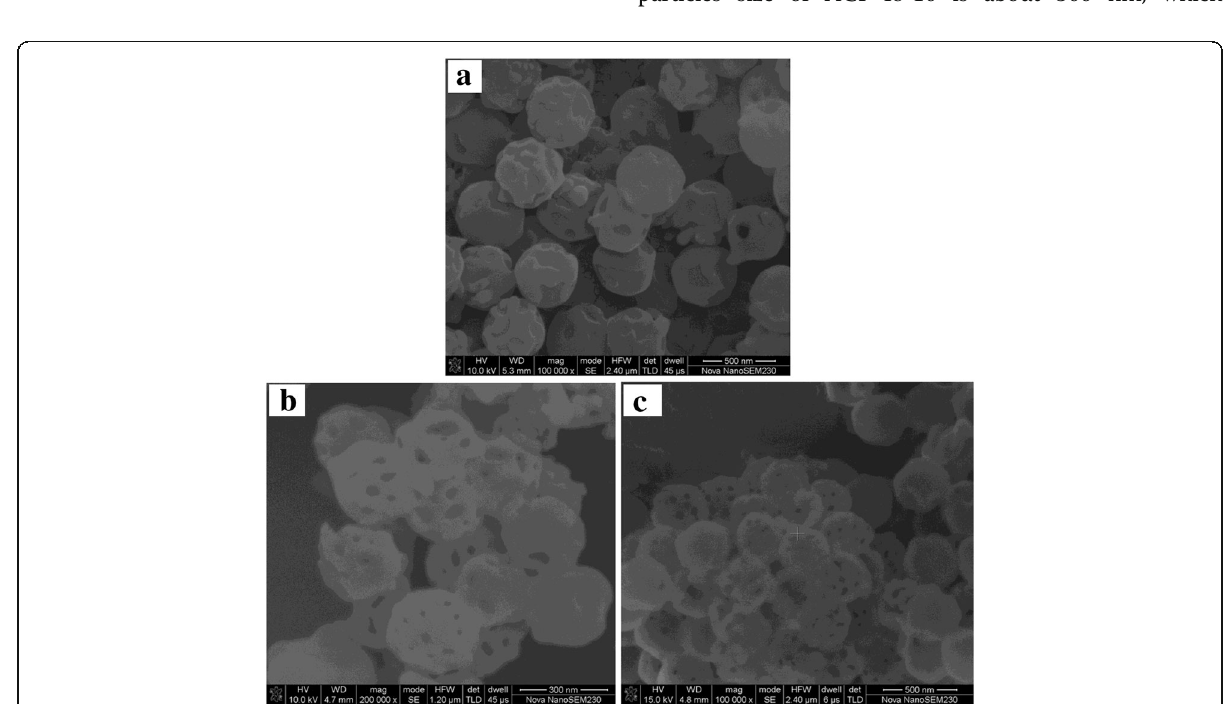
Fig. 2 SEM images of ACP-24-2 ( a ), ACP-48-2 ( b ), and ACP-48-10 ( c )